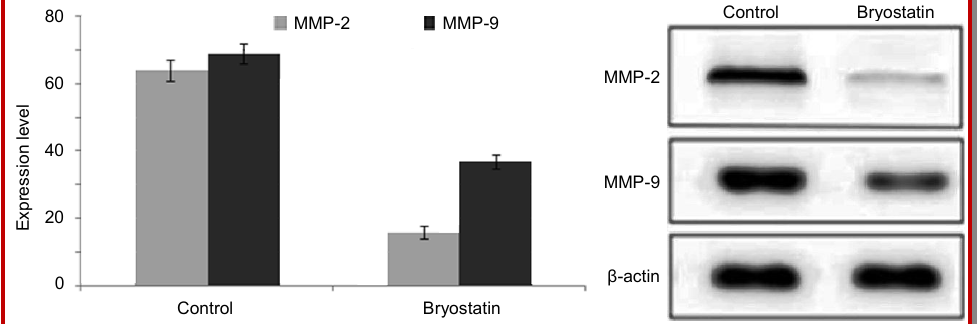
Figure 6: Effect of bryostatin I on the activity of matrix metalloproteins. H3922 cells after incubation with bryostatin I for 48 hours or DMSO as control were examined for the expression of MMP-2 and MMP-9 by Western blot